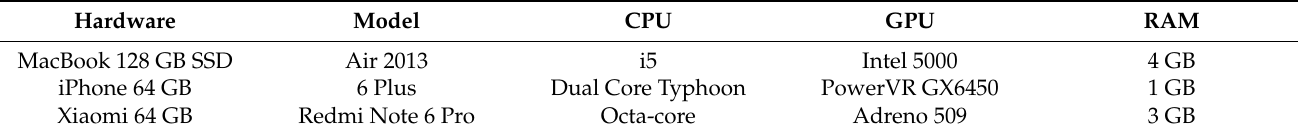
Table 1. The hardware in this